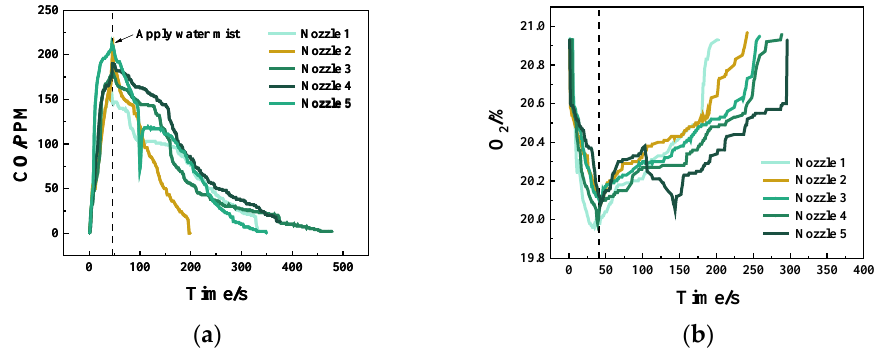
Figure 11. Variation diagram of gas concentration under different particle sizes: ( a ) is a graph of the change in CO concentration, ( b ) is a graph of the change in O 2 concentration.